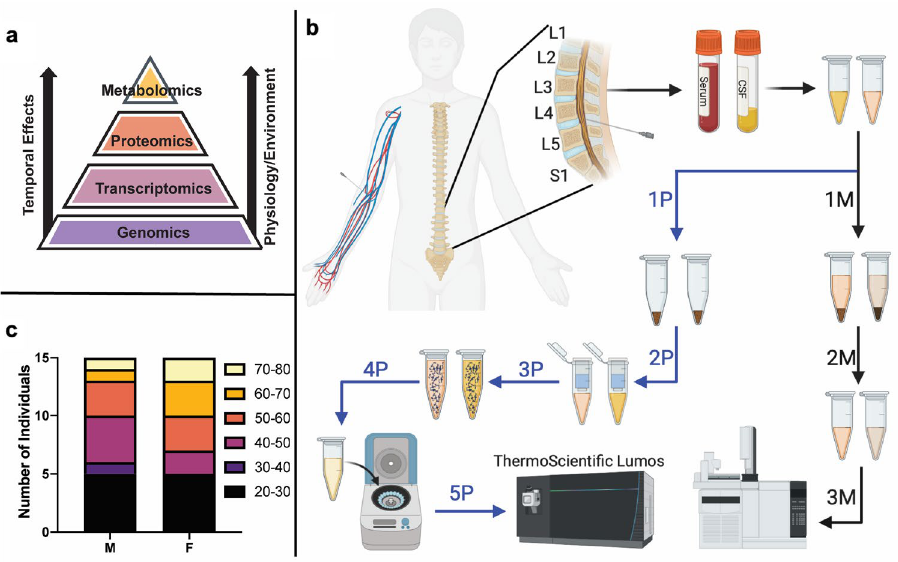
Figure 1. ( a ) Hierarchy of ‘omics where the metabolome and proteome are temporally more sensitive to environmental influence such as disease and injury. ( b ) Sample acquisition and processing scheme for Proteomics (left) and metabolomics (right) CSF samples (blue icons) were drawn by lumbar puncture (S1–L5) and serum samples (red icons) were drawn by venipuncture. Proteomics processing follows the left workflow with lyophilization (1P), resuspension and solubilization (2P), proteins were adhered to the S-Trap column (3P), the fixed proteins were washed (4P), proteins were digested overnight with trypsin (5P), the peptides were eluted (6P), dried and suspended for LC–MS/MS analysis (7P). Metabolomics processing follows the right workflow by organic solvent extraction and separation (1 M), followed by concentration and resuspension (2 M) for GC–MS analysis (3 M). C) Age/sex breakdown of the 30 CSF and 30 serum